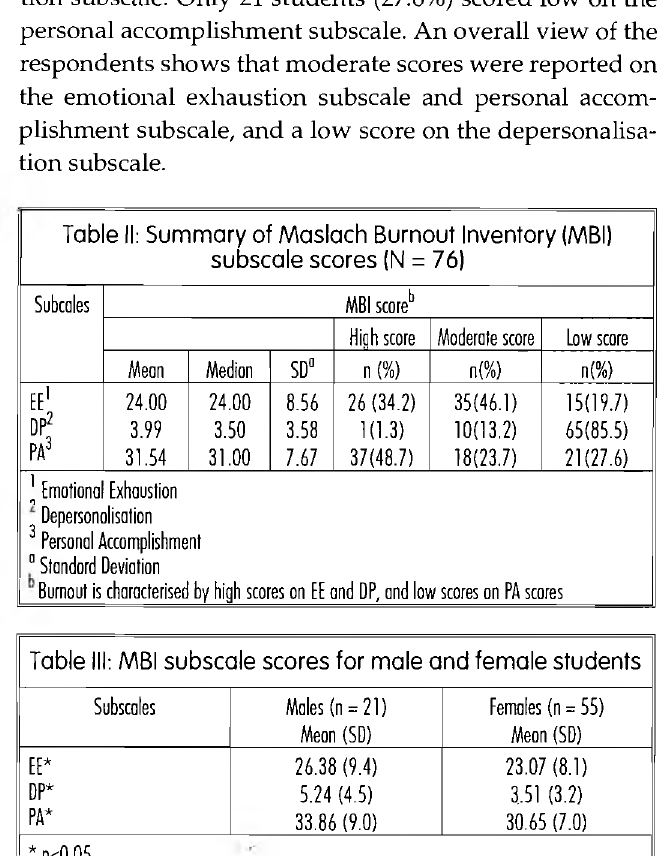
Table II: Summary of Maslach Burnout Inventory (MBI)